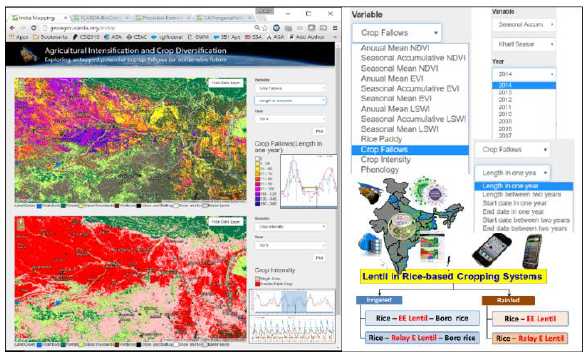
Fig. 1. Spatial Big-data based digital agricultural platform for ecological intensification of rice fallows in India